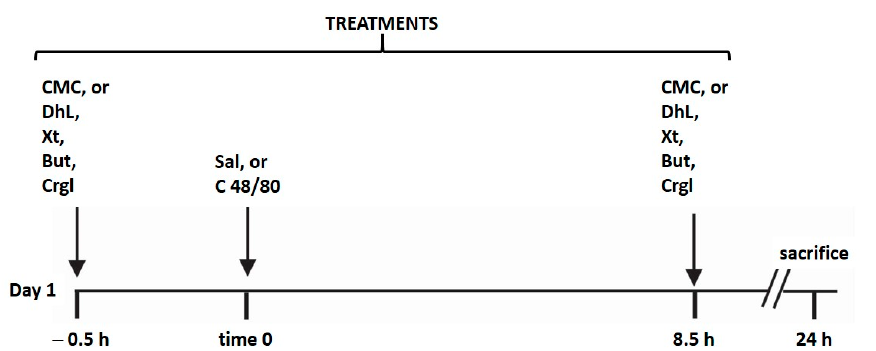
Figure 8. Schematic representation illustrating the experimental design of the study. The animals ( n = 100) were randomly divided into ten groups ( n = 10 in each group). Each group was treated as detailed in the scheme. Treatments of all groups were repeated for four days. CMC: 0.4% carboxy- methylcellulose; DhL: 40 mg/kg BW dehydroleucodine; Xt: 40 mg/kg BW xanthatin; But: 40 mg/kg BW 3-Benzyloxymethyl-5 H -furan-2-one; Crgl: 40 mg/kg BW sodium cromoglycate; Sal: saline solution; C 48/8: 0.75 mg/kg BW compound 48/80.